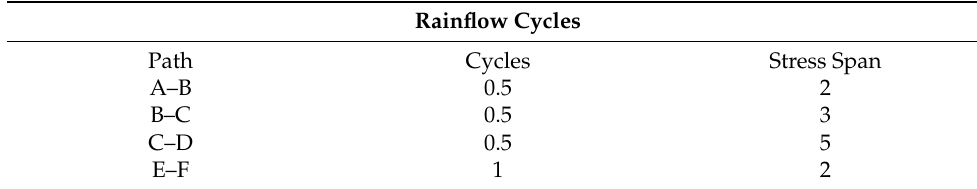
Figure 3. Rainflow diagram. Table 1. Rainflow cycling